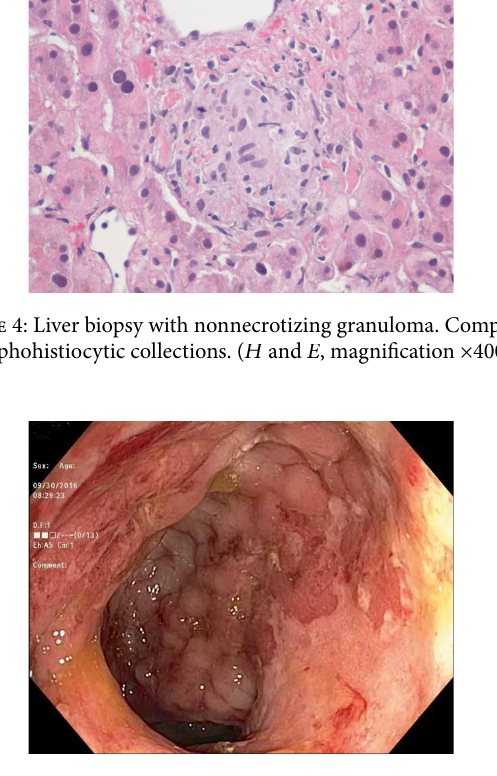
Figure 5: Friable rectal mucosa with edema (2 months after initiation of MAI